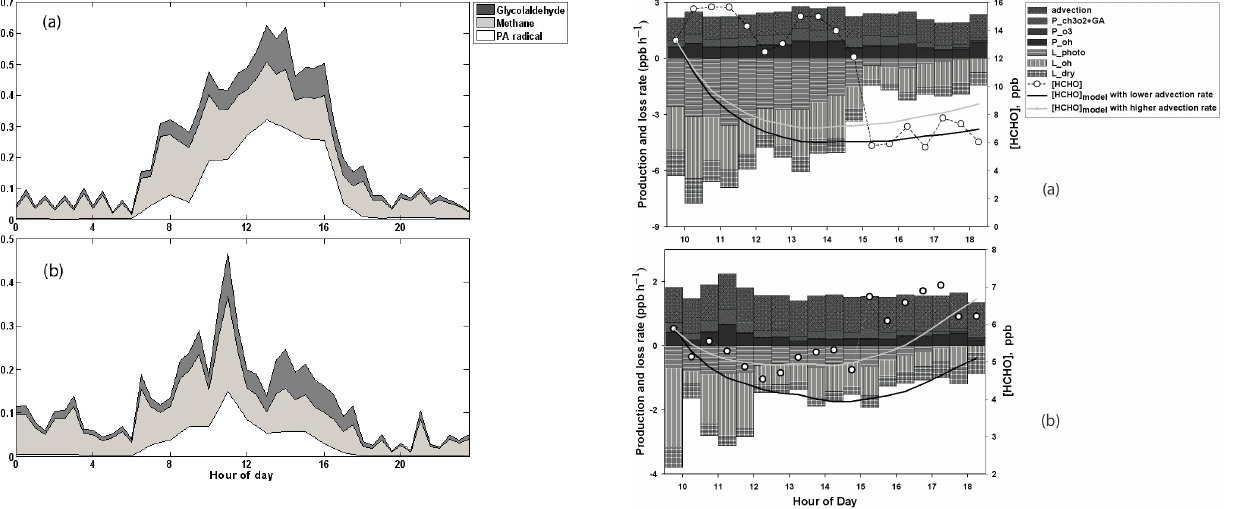
Fig. 12. Total mean daytime production and loss rates (left y-axis) and the concentrations (right y-axis) of HCHO (a) for the High and (b) Low HCHO period. Bar plots denote production and loss rates estimated from the observations (P: production, L: loss, and sub- scripts represent reaction pathways such as oh: by OH, o3: by ozone, ch3o2+GA: from methyl peroxy radical and glycolalde- hyde, photo: by photolysis, and dry: by dry deposition). White circles with dotted line denote the observed [HCHO] obs . Thick gray and black lines show the calculated [HCHO] model using a time de- pendent integration of the mean HCHO production and loss rates initialized by [HCHO] obs at 09:30 with a constant advection rate of 0.7 and 1.2 ppbh − 1 ,